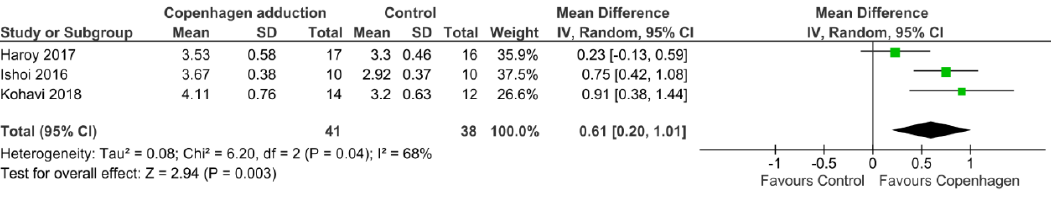
Figure 2. Meta-analysis results of CA exercise intervention on eccentric hip adduction strength (EHAD).